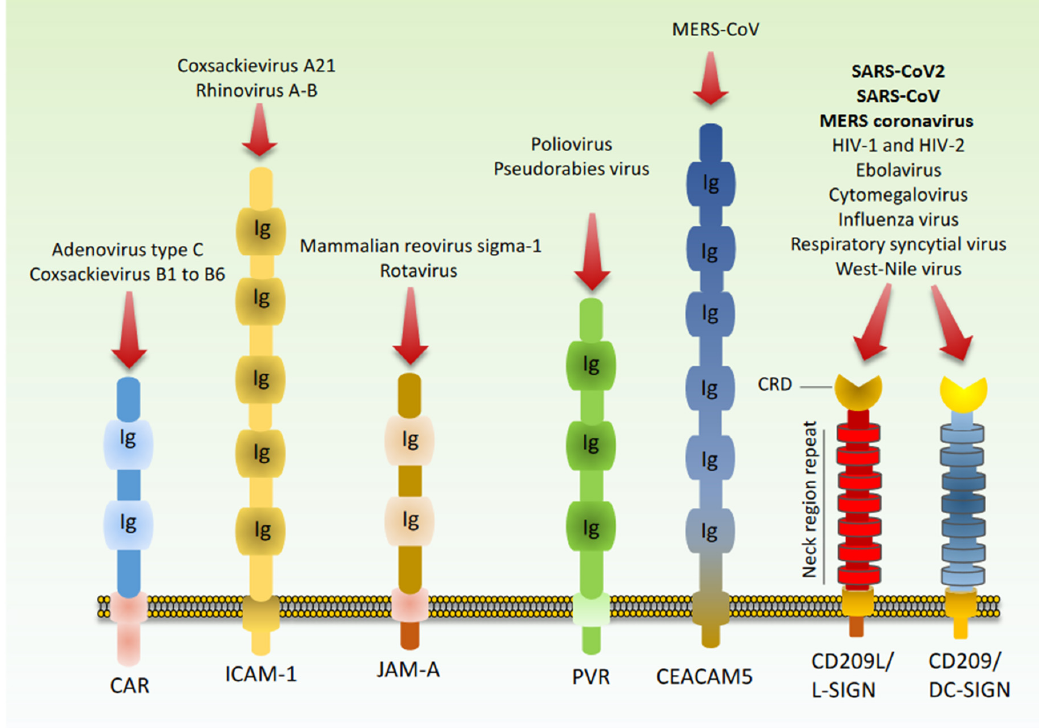
Figure 4. Cell adhesion of molecules are common receptors for viruses. Schematic of the most common cell adhesion molecules involved in virus recognition and viral cell entry. Coxsackievirus-adenovirus receptor (CAR) [127], intercellular adhesion molecule 1 (ICAM 1/CD54) [128], junctional adhesion molecule A (JAM-A) [129,130], and poliovirus receptor (PVR/CD155) [131]. MERS-CoV also employs carcinoembryonic antigen-related cell adhesion molecule 5 (CEACAM5) [132]. CLEC4M, (also known as L-SIGN and CD209L) and CAM, dendritic cell-specific ICAM-3 grabbing non-integrin (DC-SIGN, also called CD209) binds to Ebolavirus [133], Hepatitis C virus [134], human coronavirus 229E [135], Human cytomegalovirus/HHV-5 [136], Influenza virus [137], West-Nile virus [136], Japanese encephalitis virus [138], SARS-CoV [136,139,140], and SARS-CoV-2 [120].